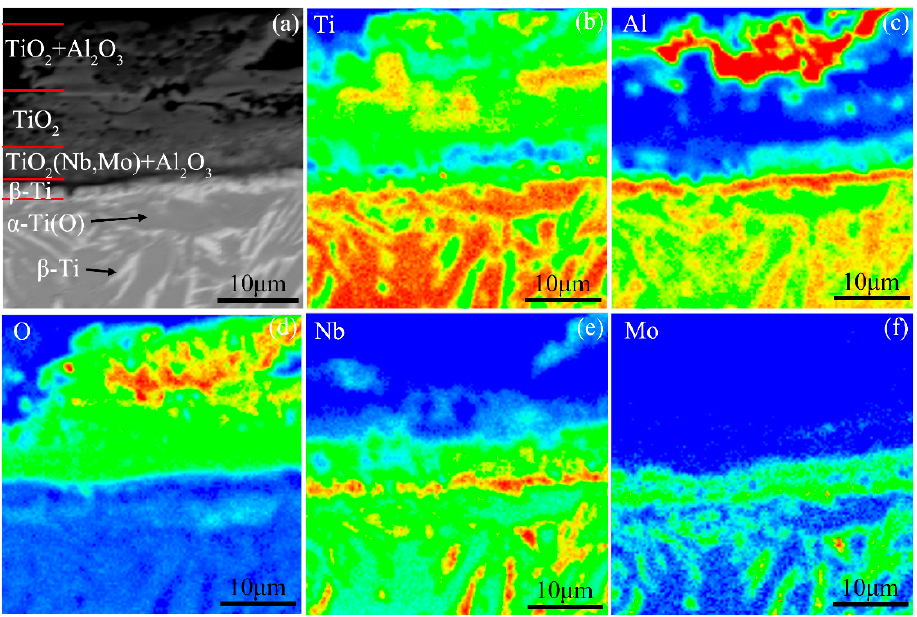
Figure 8. ( a ) Cross-sectional morphology and ( b – f ) the corresponding elemental distribution maps of the oxide scale formed during heating the Ti-24Al-15Nb-1.5Mo alloy to the end of Stage III.